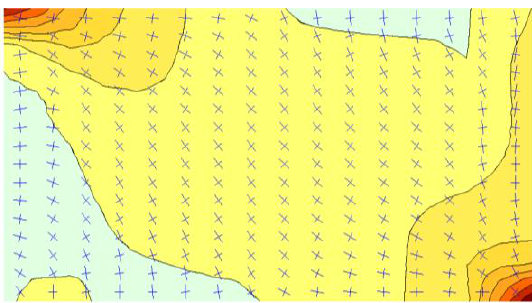
Fig. 3. Map of tensile stress in an ordinary wall. The maximum tensile stress is 38 kN/m 2 .